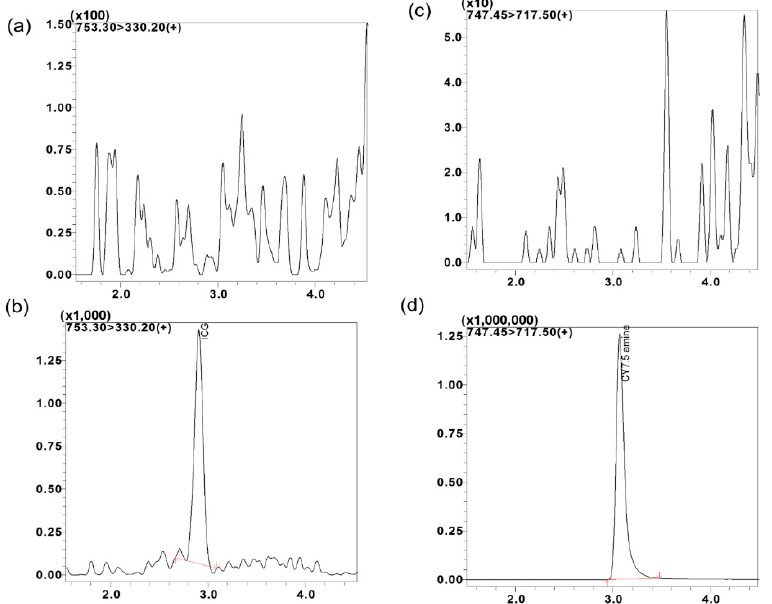
Figure 3. Representative MRM ion-chromatograms of ( a ) blank rat plasma using the conditions for ICG detection, ( b ) ICG spiked in rat plasma at LQC (rt. 2.8 min, 3.0 ng/mL), ( c ) blank rat plasma using the conditions for Cy7.5 detection, and ( d ) Cy7.5 spiked in rat plasma (rt. 3.1 min, 77 ng/mL).